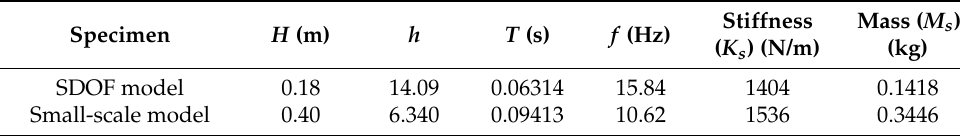
Table 4. Dynamic properties of test specimens.